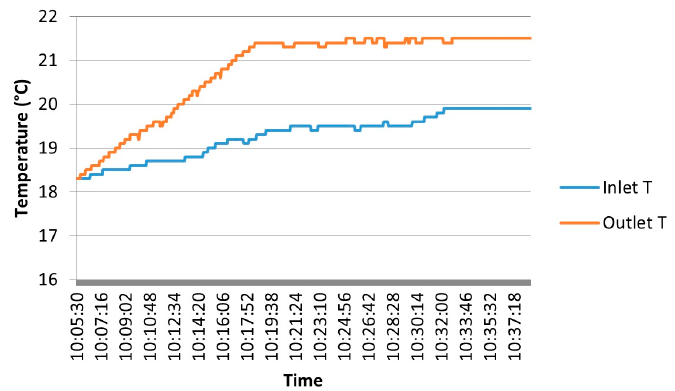
Figure 4. Plot of temperatures before stabilization for test T 3 .